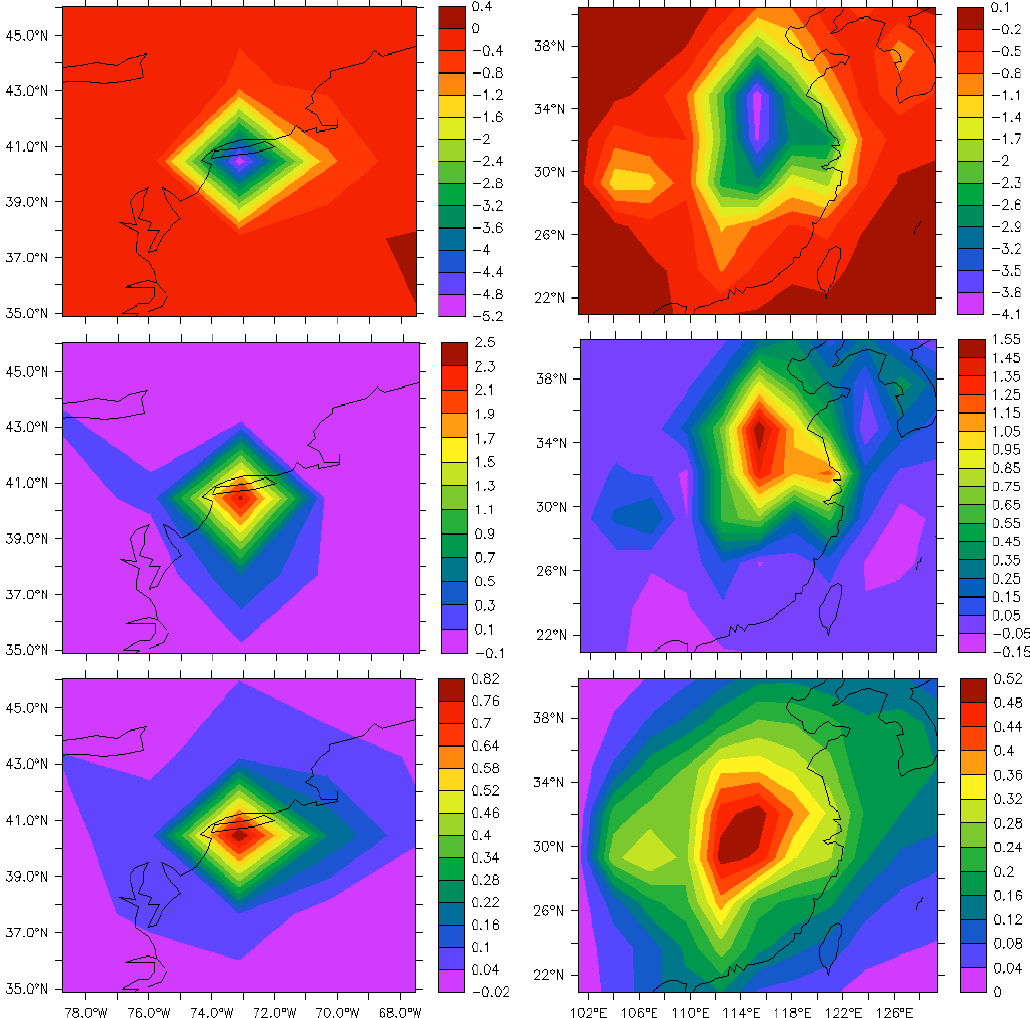
Figure 18: Simulated monthly average enhancement of NO x (upper panel), HNO 3 (middle panel) and PAN (lower panel) in ppbv near the surface in June over the eastern USA (left) and December over eastern China (right).